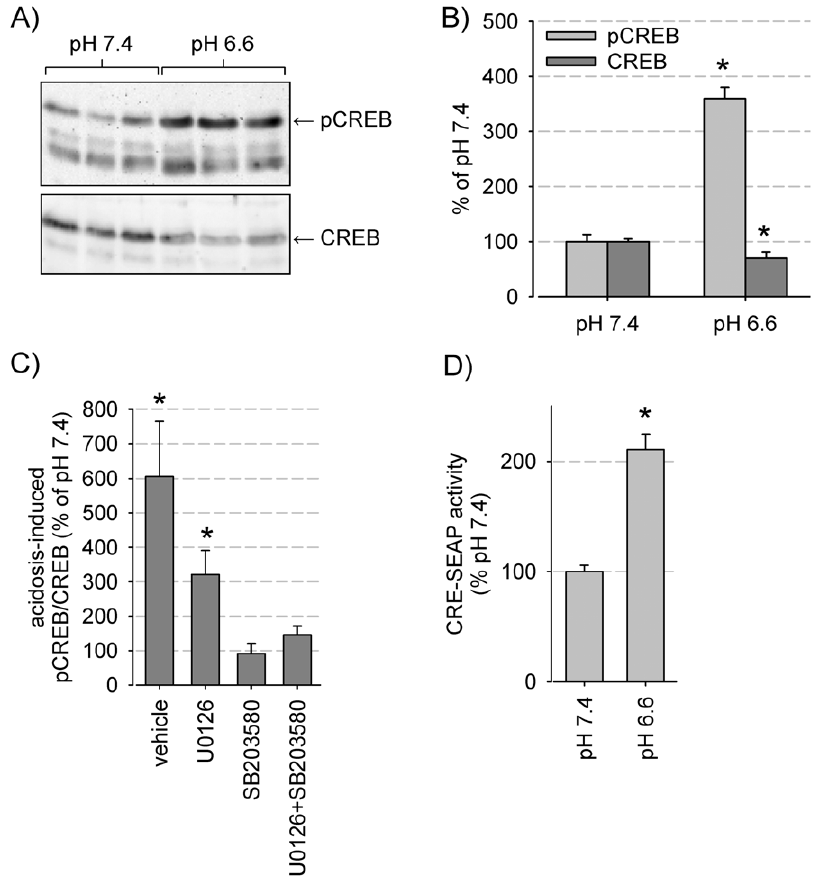
Figure 8. Impact of acidosis and MAPK activation on CREB phosphorylation and CRE activity. (A) Typical western blot for phosphorylated and overall protein of CREB in AT1 after an incubation period of 3h in either pH 7.4 or pH 6.6. (B) Impact of extracellular pH on total CREB and CREB phosphorylation. Measured pCREB and CREB levels were normalized to pH 7.4 (N=8). The shown values describe the induction of expression compared to control values (pH 7.4) on the same blot. (C) Impact of inhibition of ERK1/2 (U0126) and/or p38 (SB203580) on acidosis-induced CREB phosphorylation (N=3). Values shown describe the induction of CREB phosphorylation by pH 6.6 compared to that found at 7.4 in the absence or presence of MAPK inhibitors. Significance was calculated from the comparison of pCREB/CREB at pH 6.6 + inhibitor with pH 7.4 + inhibitor. (D) CRE activity (measured by the CRE-SEAP reporter gene assay) under control or acidic conditions (N=20). (*) p , 0.05.